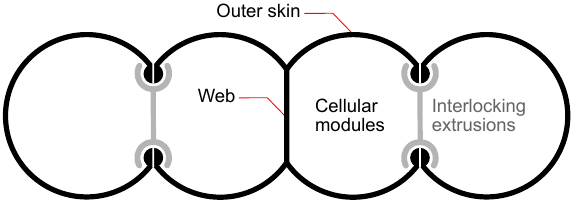
Figure 2. Schematic of the tank design by PPI, New Zealand